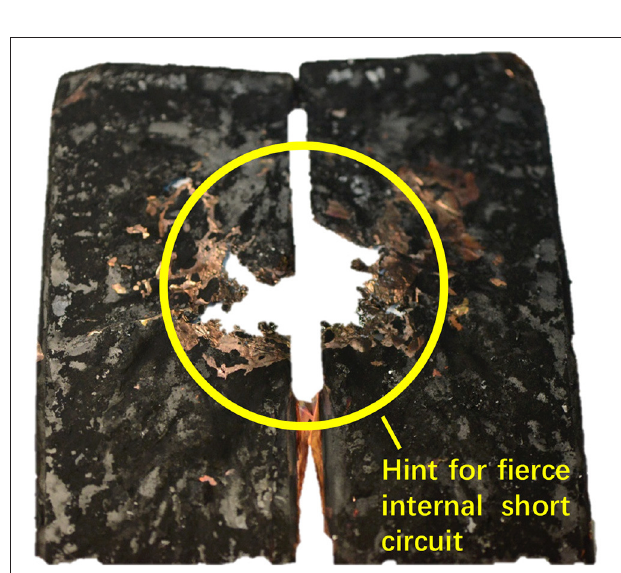
FIGURE 11 | The hint for fierce internal short circuit during thermal runaway